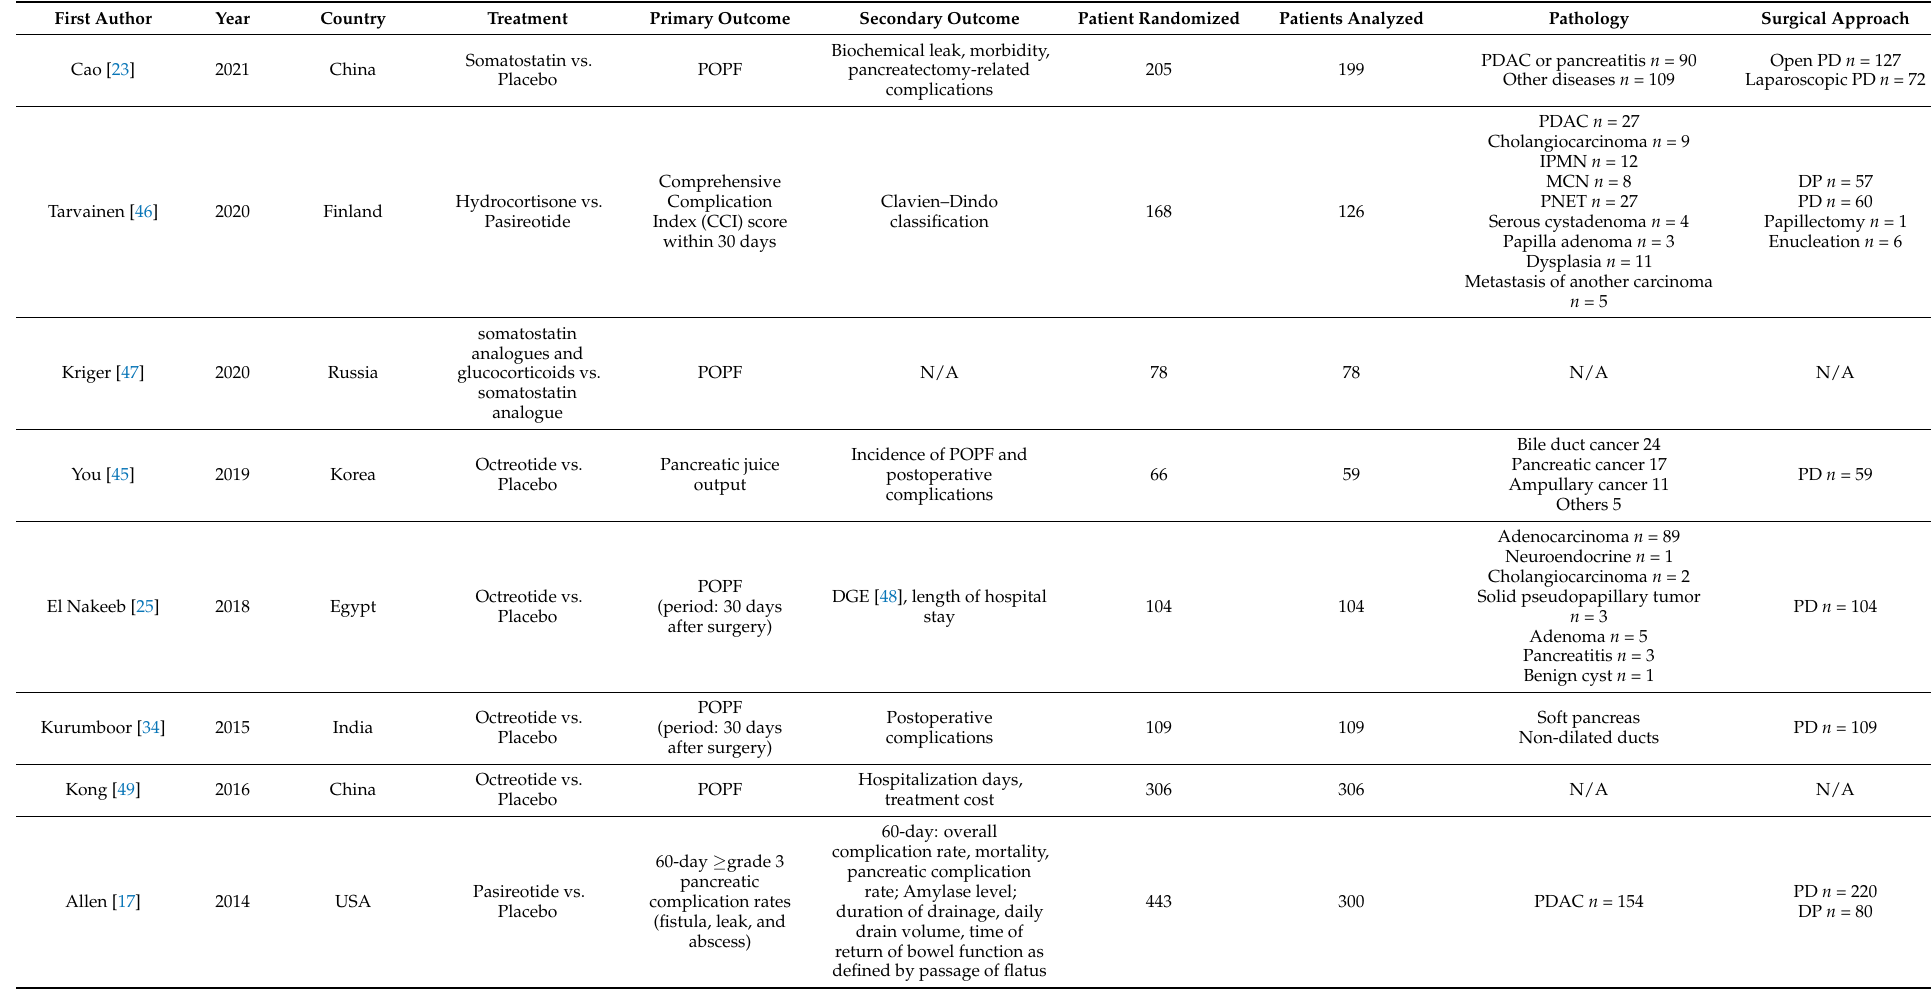
Table 1. Somatostatin and